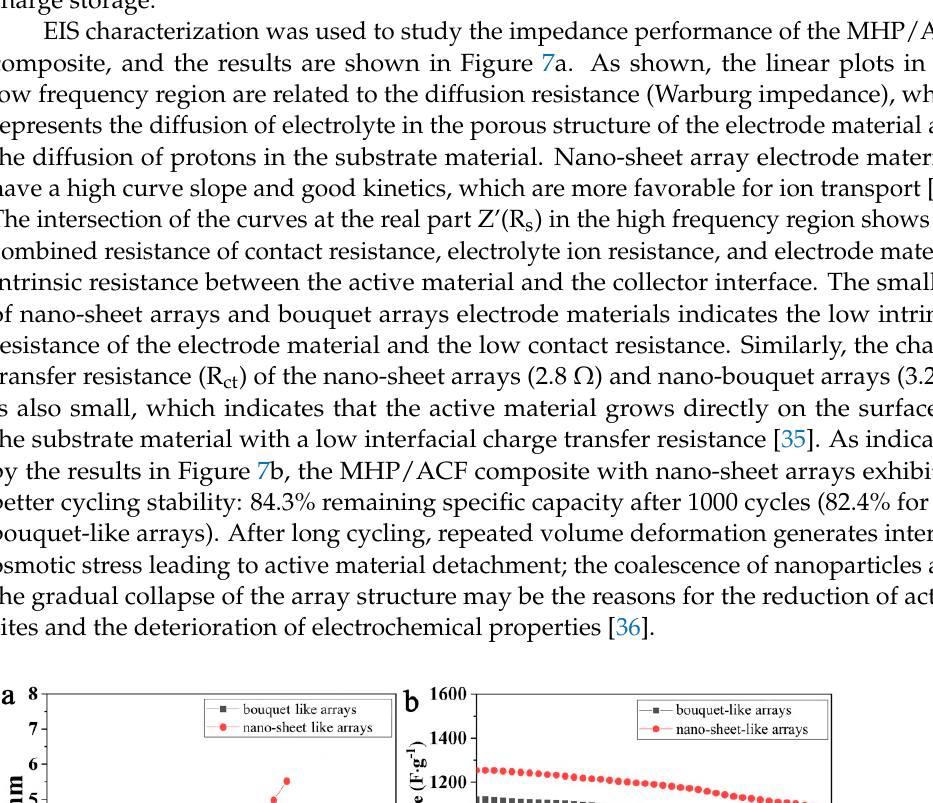
Figure 8. ( a ) Stress-strain curves of the MHP nano-sheet arrays/ACF composite (the inset figure is the digital image of bended sample); ( b ) CV curves of MHP nano-sheet arrays/ACF composite elec- trode before and after stretching.